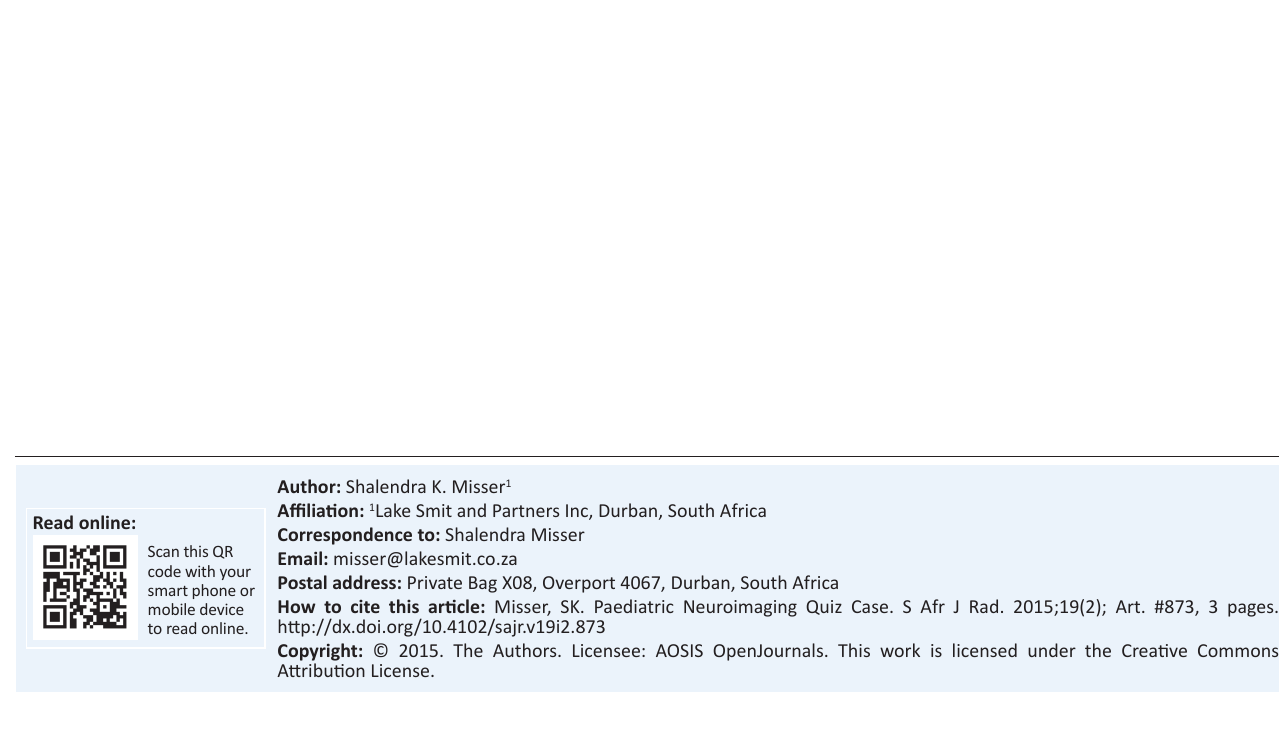
FIGURE 1: Axial T2-weighted MR image. FIGURE 2: Axial FLAIR MR